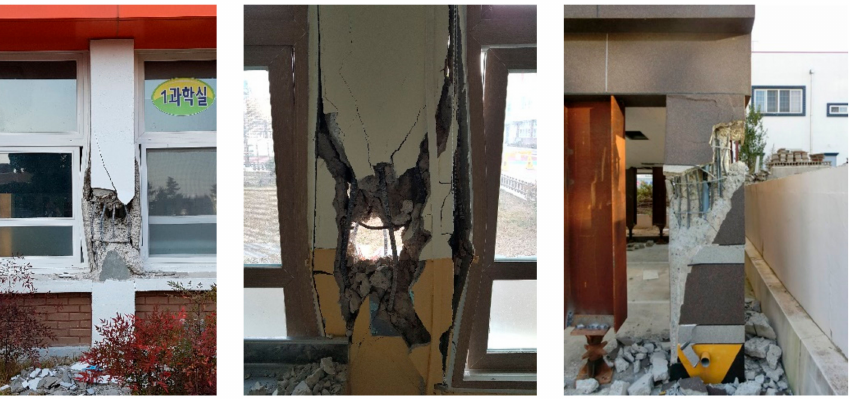
Figure 1. RC buildings damaged by shear failure after the 2017 Pohang